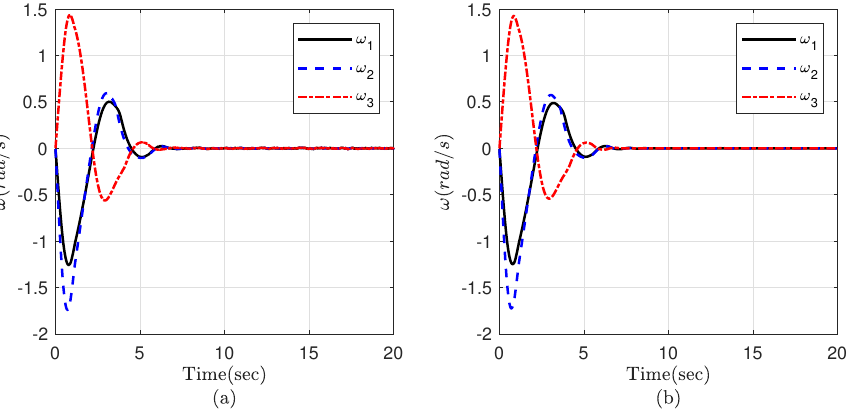
Figure 17. The rotation velocity in Part 3: ( a ) noisy measurement, ( b ) high-frequency